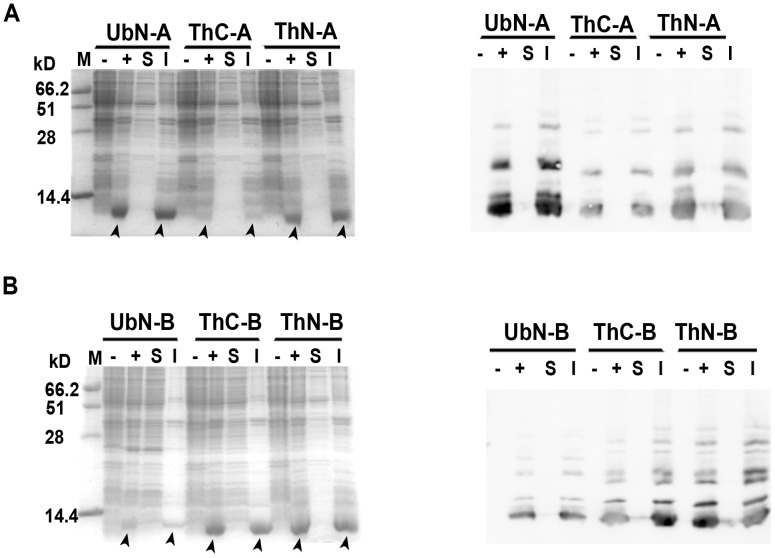
Expression of Insulin chains fused with half-molecules of ThiS or Ubiquitin.Insulin A chain (A) or B chain (B) fused with the N-terminal half (ThN-) or C terminal half (ThC-) of ThiS or the N-terminal half of ubiquitin (UbN-), were expressed in E. coli BL21 (DE3) pLysS. Total cell lysate from uninduced (−) or induced (+) cells with IPTG, and the soluble (S) or insoluble fraction (I) of induced cell were resolved on 15% SDS-PAGE, shown in left panels. M indicates Marker proteins. Western blot probed with anti His-tag antibody were shown in right panels. Arrowheads highlight observed positions of expressed proteins.